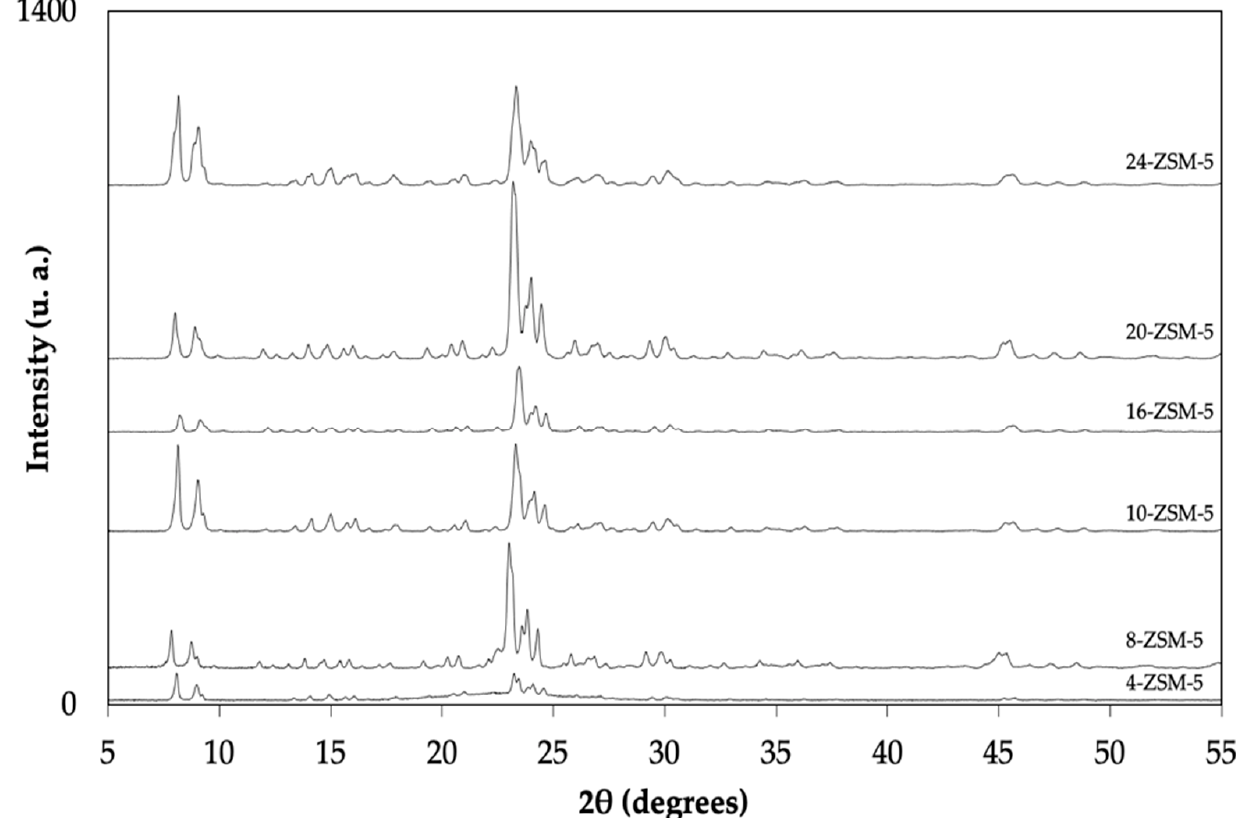
Figure 1. XRD patterns for the ZSM-5 that were synthesized using TPAOH.